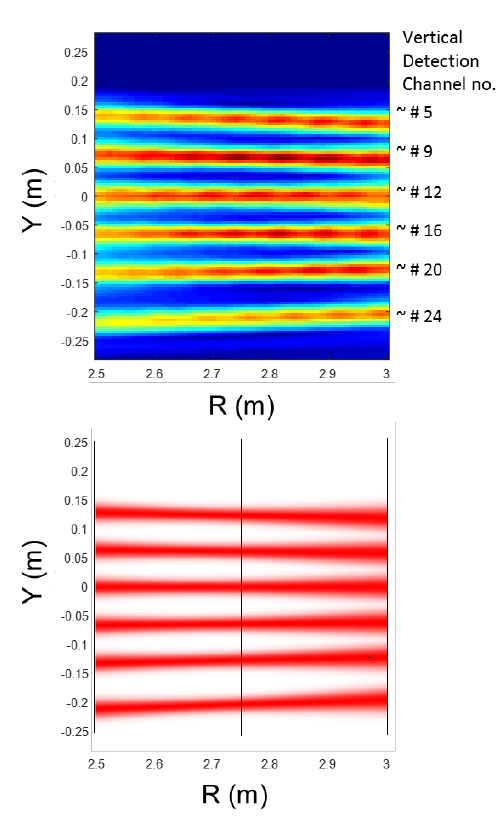
Fig. 11. Beam pattern (vertical direction) along the major radius. The white spot shows the position of the focal